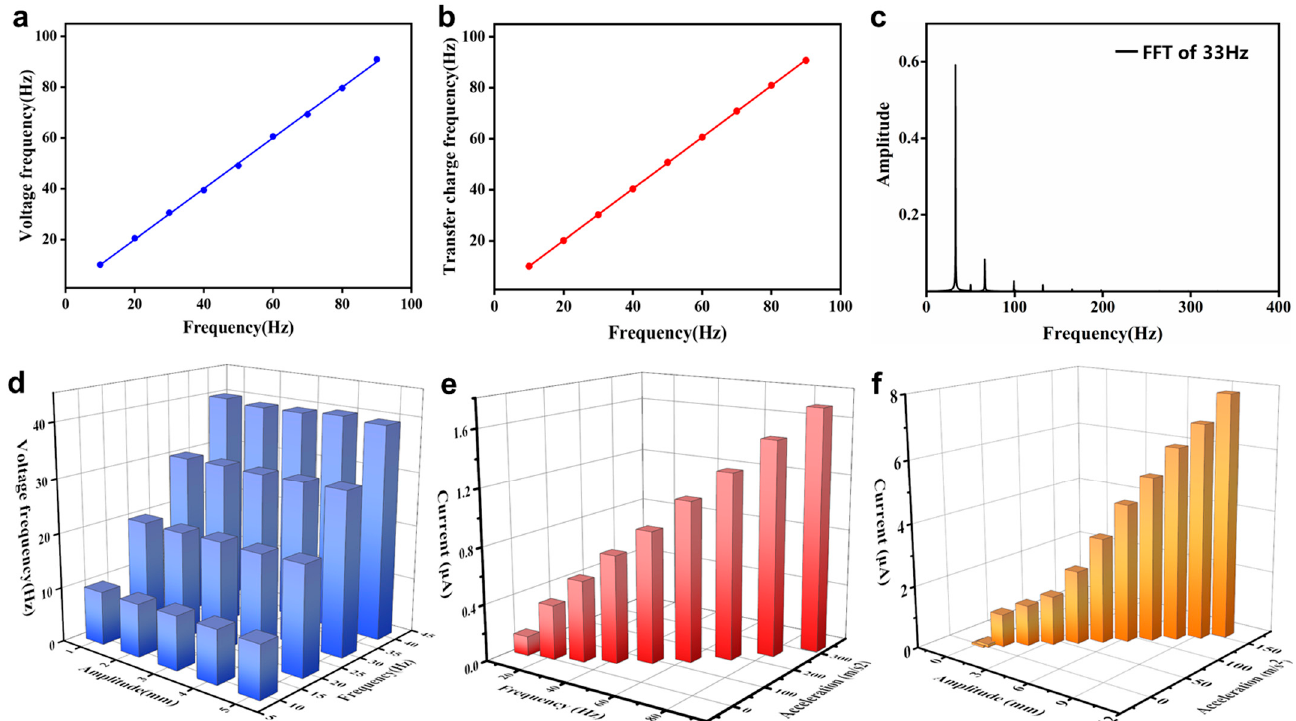
Figure 5. Vibration sensing performance of the SRS-TENG. ( a ) Linear relationship between FFT of voltage signal and vibration frequency with the vibration amplitude of 1 mm. ( b ) Linear relationship between FFT of transferred charge signal and vibration frequency with the vibration amplitude of 1 mm. ( c ) The FFT result of voltage signal with the vibration frequency of 20 Hz and amplitude of 1 mm. ( d ) 3D relationship between the FFT result of voltage signal and vibration frequency with different fixed amplitude. ( e ) Relationship between short-circuit current, vibration frequency and acceleration with the fixed amplitude of 1 mm. ( f ) Relationship between short-circuit current, vibration amplitude and acceleration with the fixed frequency of 20 Hz.